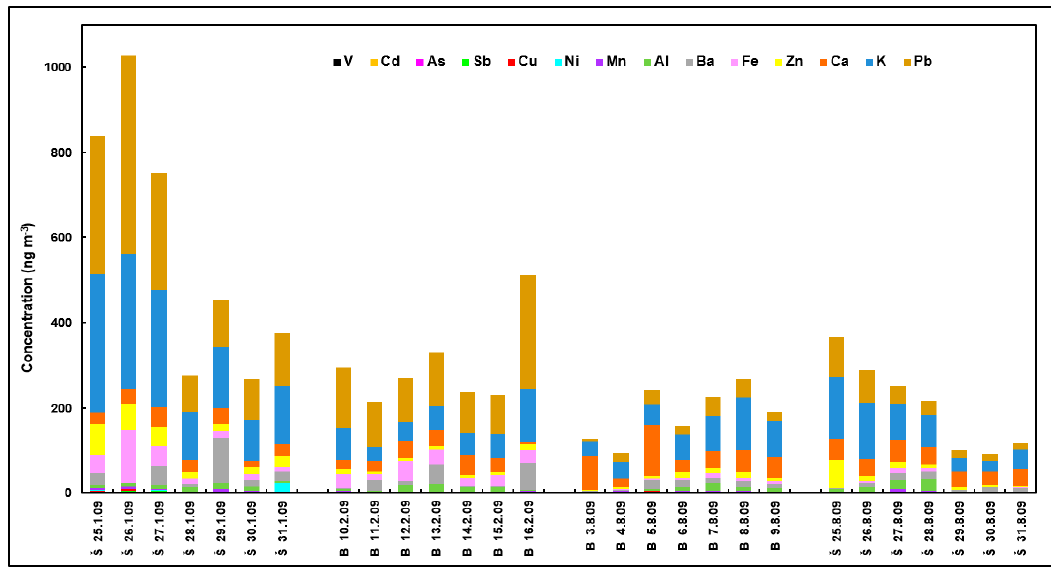
Figure 2. Daily variations in the concentrations of elements in the PM 1 aerosols in Brno and Šlapanice in 2009.